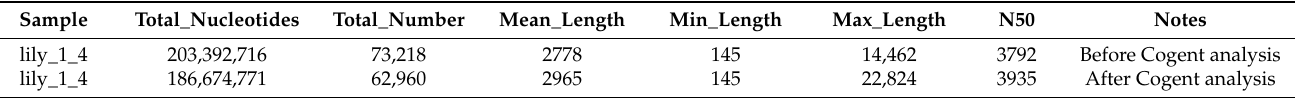
Table 1. Statistics of SMRT sequencing data before and after Cogent analysis.